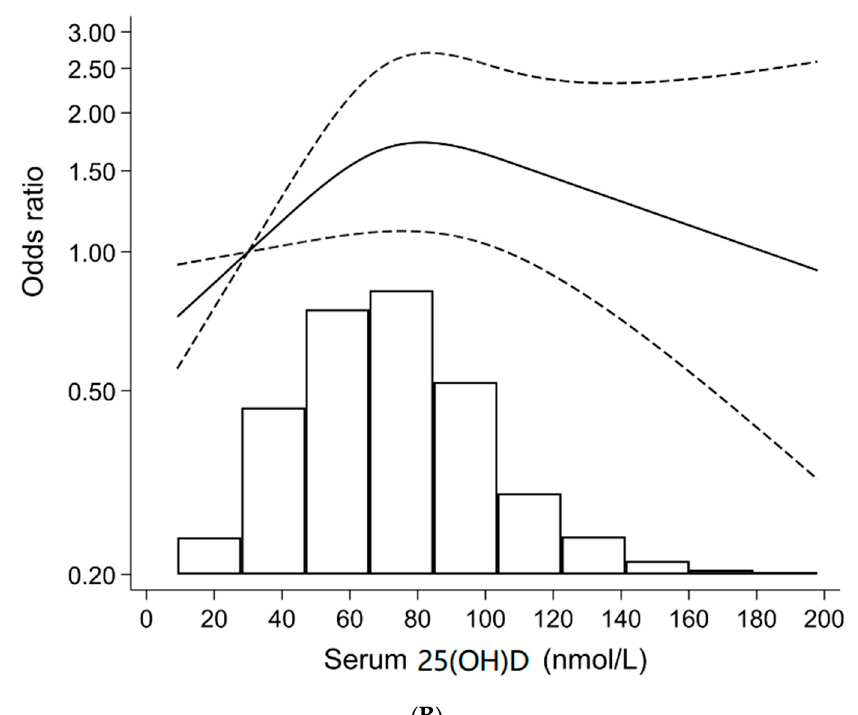
Figure 2. Association between serum 25-hydroxyvitamin D [25(OH)D] concentration and breast cancer prevalence in all postmenopausal women (n = 8108) ( A ) and in non-Hispanic white postmenopausal women (n = 4301) ( B ) using combined National Health and Nutrition Examination Surveys, 2001–2014. Models were adjusted for age, race-ethnicity, poverty income ratio, education, physical activity, season of survey, smoking, alcohol consumption, BMI, and hormone replacement therapy. Restrict cubic spline method was used in the logistic regression to analyze the nonlinear association between serum 25(OH)D concentration and breast cancer prevalence in all women ( A ) ( p = 0.014) and in non-Hispanic white women ( B ) ( p = 0.031). Three knots were put at 5th, 50th, and 95th percentiles of serum 25(OH)D concentrations. The risk of breast cancer was highest between 70 nmol/L and 80 nmol/L of serum 25(OH)D concentration in all women ( A ), in non-Hispanic white women ( B ), and in non-Hispanic black women (OR = 1.5). Relation for non-Hispanic blank, Mexican American/Hispanic, and Other Race-Ethnicities is not presented for simplicity.